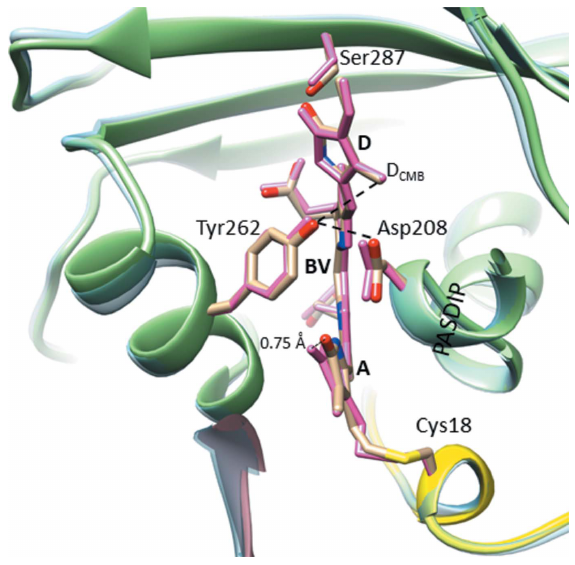
Figure 7 Superposition of the T289H mutant SaBphP1-PCM structures deter- mined at cryo (PAS, yellow; GAF, green; PHY, not shown) and at room temperatures (light-blue ribbon). The chromophore binding site is enlarged and important residues, the PASDIP consensus sequence and the BV chromophore are marked. Dark yellow residues from cryo structure; hot pink from the room-temperature